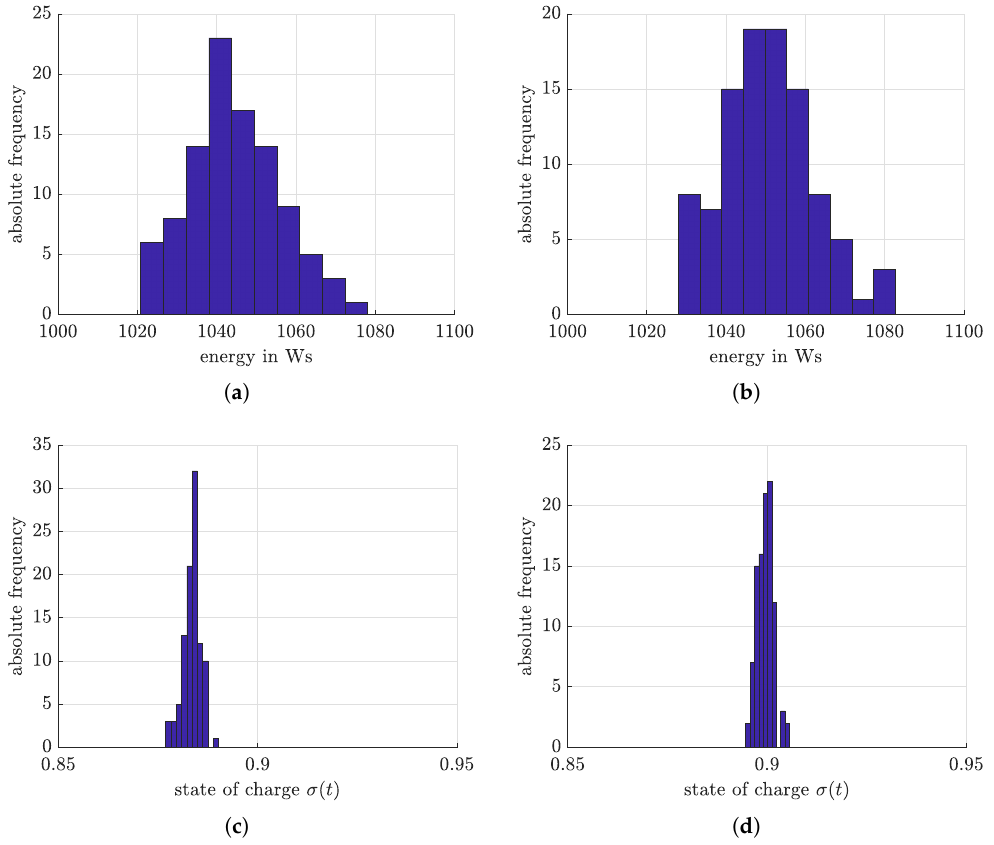
Figure 10. Sensitivity of the Ohmic losses and the terminal SOC for the feedback control approach. ( a ) Variability of the Ohmic losses occurring on the time interval t ∈ [ 0 ; 3600 ] s; ( b ) Variability of the Ohmic losses occurring on the time interval t ∈ [ 0 ; 7200 ] s; ( c ) Variability of the SOC at t = 3600s; ( d ) Variability of the SOC at t =